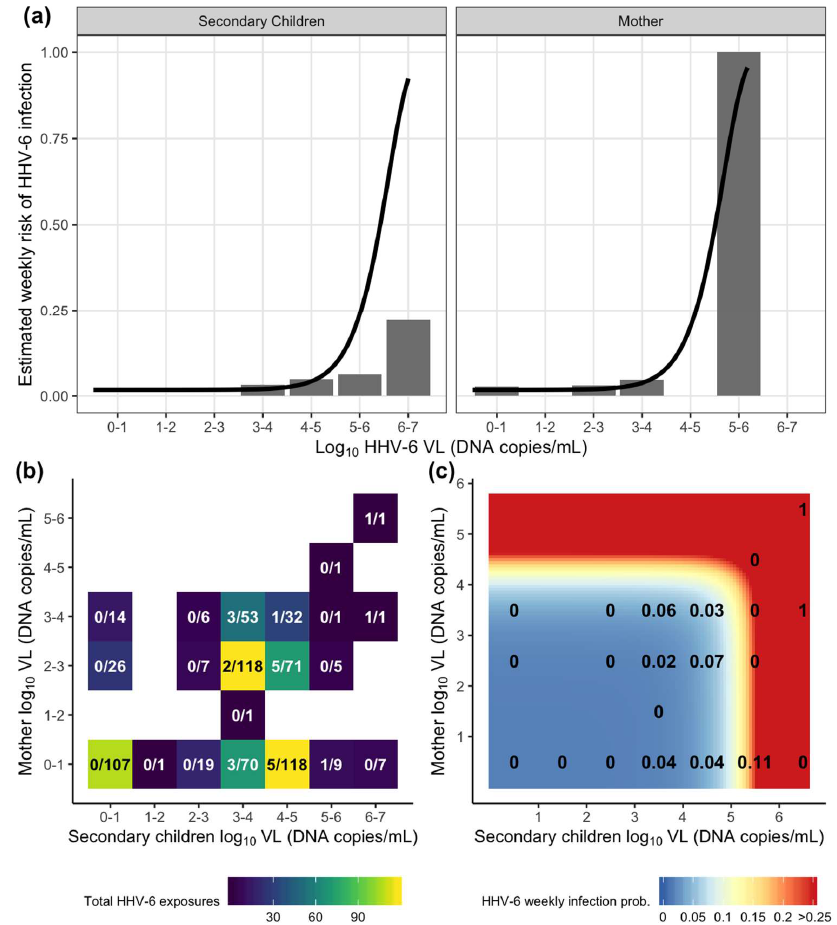
Figure 3. Estimation of HHV-6 acquisition risk from exposures by week using the combined exposure model (Tables 2 and A1). ( a ) Individual HHV-6 dose–response relationship for mother and secondary children oral viral load (VL, DNA copies / mL) exposures where bars depict the percentage of infections observed among total exposures in the data and lines depict estimated risk from the model. ( b ) A heatmap depicting the distribution of total combined exposures in a given viral load bin from mothers and secondary children in a household. The text depicts the fraction of total infections over total exposures. ( c ) A heatmap depicting the risk of HHV-6 infection from combined household mother and secondary children exposures estimated from the model. The text depicts the proportion of infections observed in the data using binned viral loads from (b) (equivalent to fraction